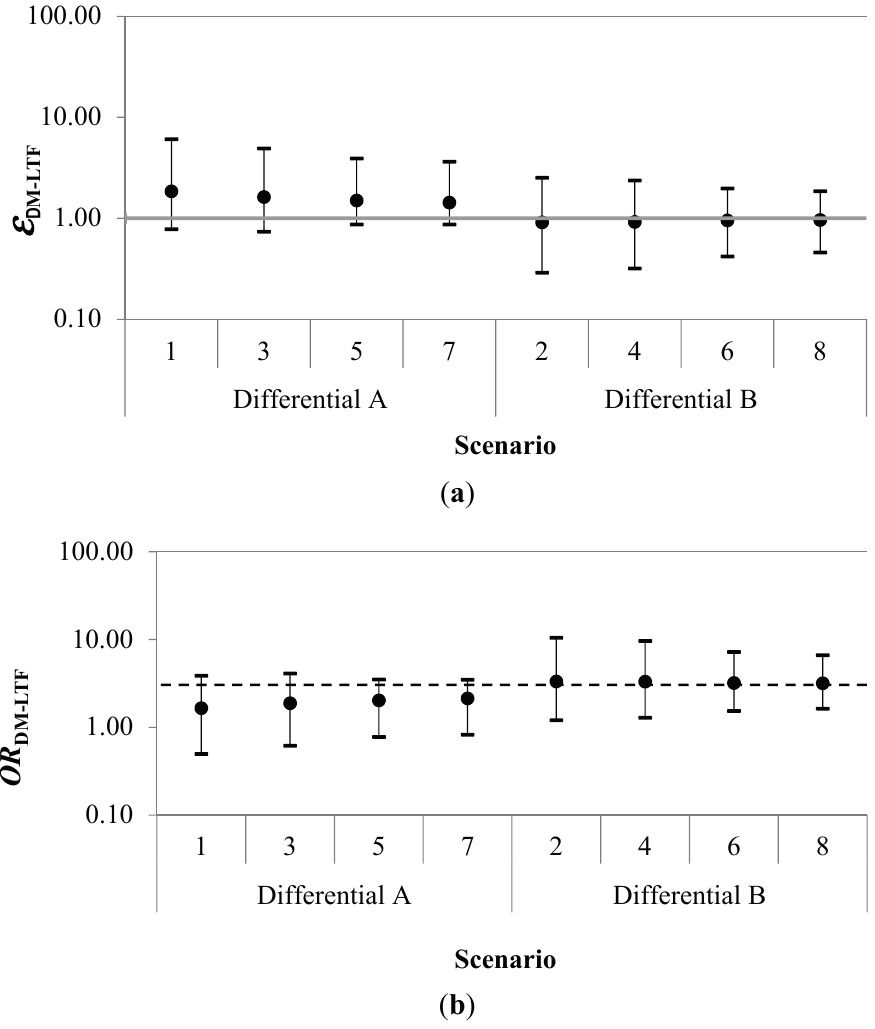
ε Figure 3. Geometric mean errors ( ) ( a ), adjusted odds ratios ( OR DM-LTF 95% certainty intervals by scenario. The dashed horizontal black line in ( b ) indicates the crude odds ratio ( OR ) of 3.05. In the Differential A scenarios, the “never-exposed” were observed